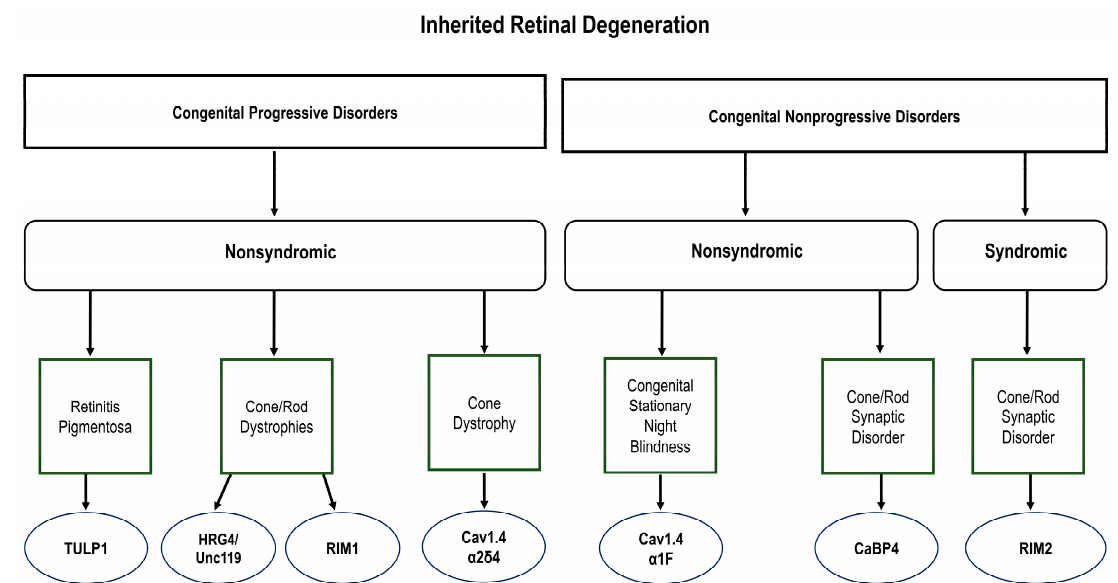
Figure 1. Inherited retinal degeneration (IRD) is a common form of vision disease in humans. Characterized by photoreceptor degeneration, mutations in the represented elements of the ribbon synapse induce both nonsyndromic and syndromic forms of these diseases. The clinical manifestations of the diseases caused by these dysfunctions are diverse. Table 1. Summary of retinal diseases caused by dysfunction of proteins localized to the ribbon presynapse.